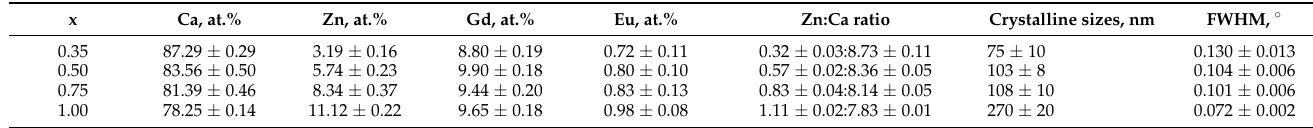
Table 1. EDX analysis results, estimated crystalline size and average full width at half maximum